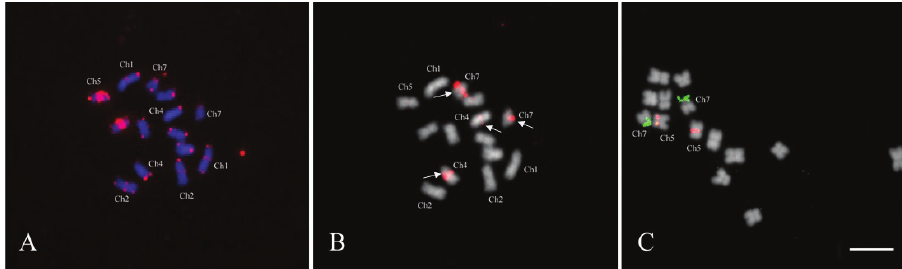
Figure 1. FISH on the chromosomes of R. wichurana . A FISH with Arabidopsis -type telomere probe (red) and 45S (green) under hybridization at 37°C B FISH with Arabidopsis -type telomere probe under the low hybridization stringency condition (23-25°C). Arrows indicate the major ITRs on chromosome 5 and arrowheads show the ITRs which are visible under the low hybridization stringency condition C The same metaphase as in 1B rehybridized with 5S rDNA under the common hybridization stringency (37°C). Arrows indicate the 5S rDNA signals. Sacale bar: 5